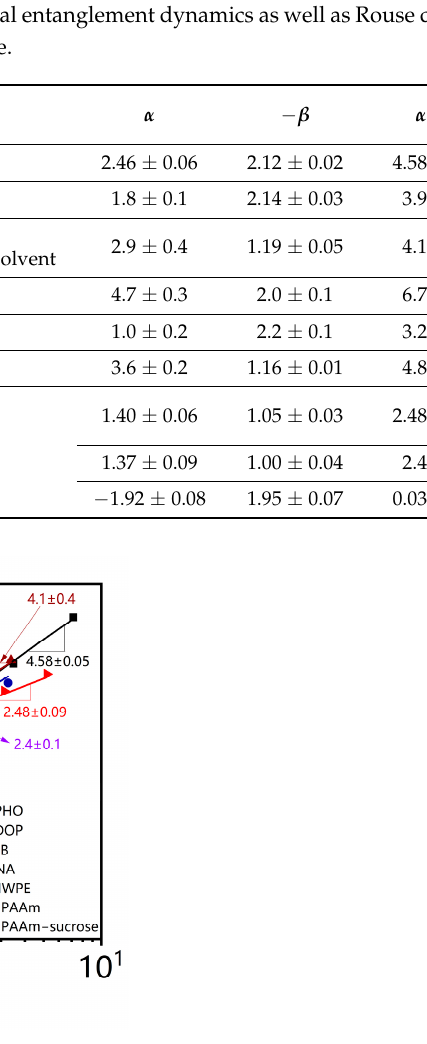
Figure 4. Plots of ( a c / b c ) as a function of ( c / c ref ) in the logarithmic scales for the polymer solutions listed in Table 1 with respect to reference concentration as c ref = 56 c * for PB–PHO [4], c ref = 44.3 c * for PB–DOP [4], c ref = 8.0 c * for PI–OB [13], c ref = 49.1 c * for λ -DNA [9], c ref = 125 c * for UHMWPE [12], c ref